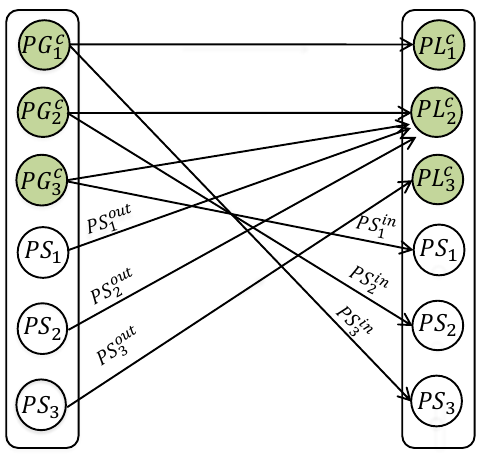
Figure 10. An equivalent imaginary